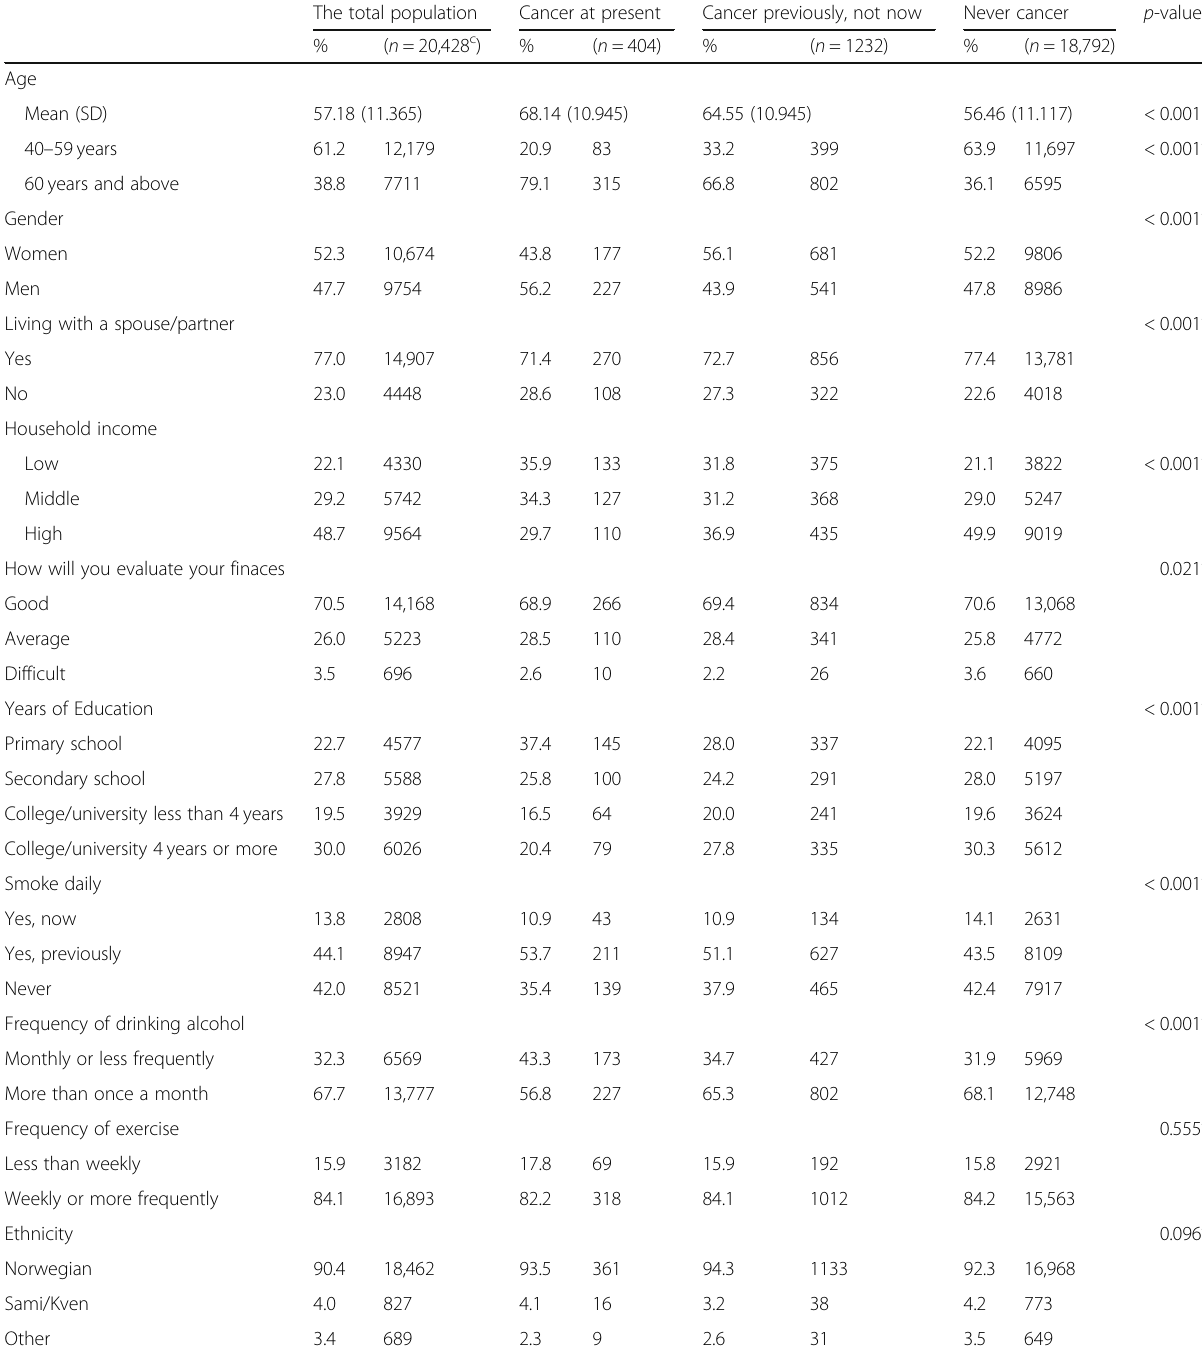
Table 1 Basic characteristics of the participants The total population Cancer at present Cancer previously, not now Never cancer p